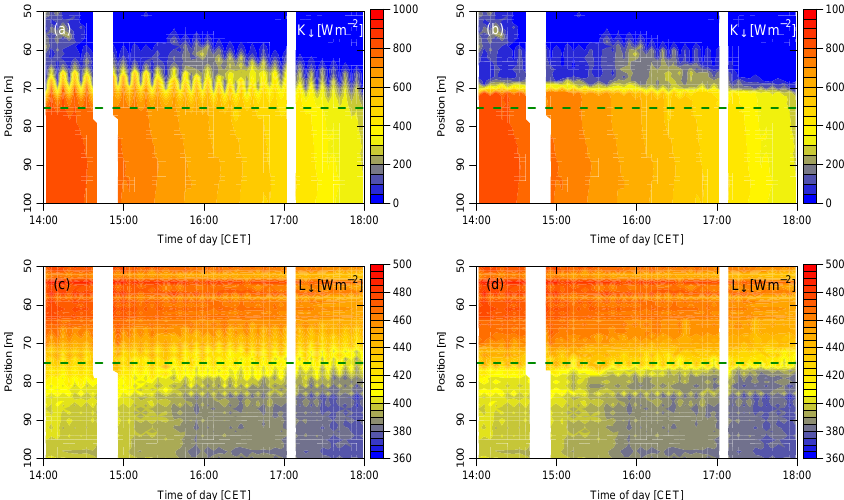
Figure 5. Detailed horizontal profiles during daytime of 28 June 2011 at the forest edge (horizontal green dotted line), uncorrected profiles for short-wave downwelling radiation K ↓ (a) and long-wave downwelling radiation L ↓ (c) , and in both cases response time corrected profiles (b, d) . Position shows distance from starting point in metres, starting in the forest (50m) and ending at the clearing (100m).